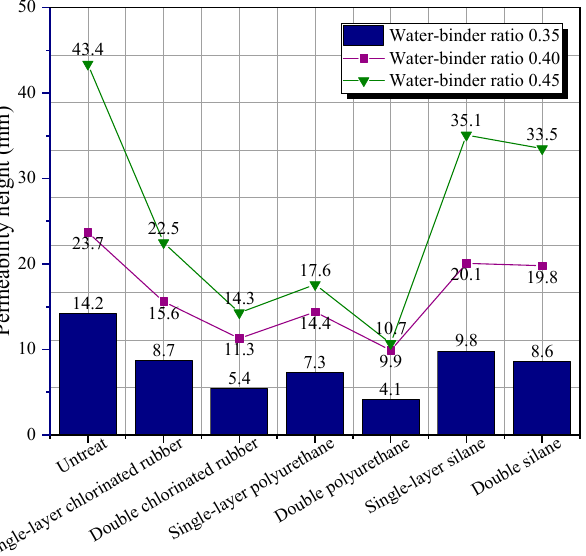
Figure 11. Permeability height of protective specimens with different water–binder ratios.